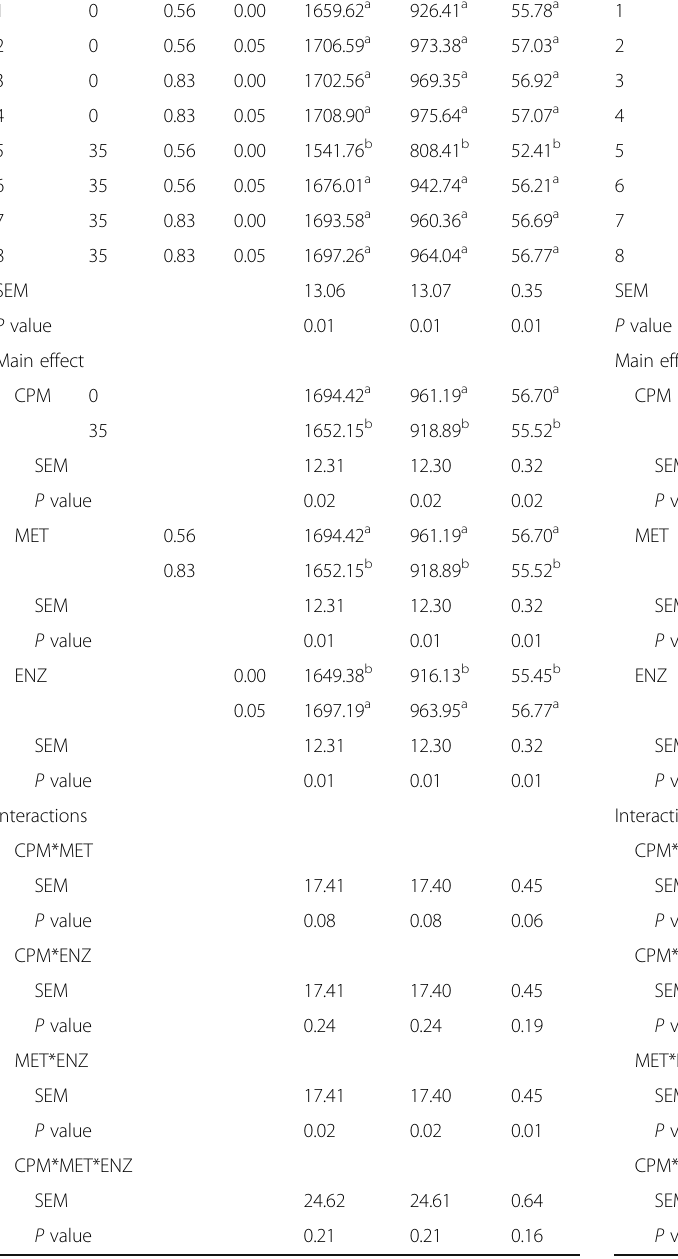
Table 6 Effect of cassava peel meal inclusion (%),